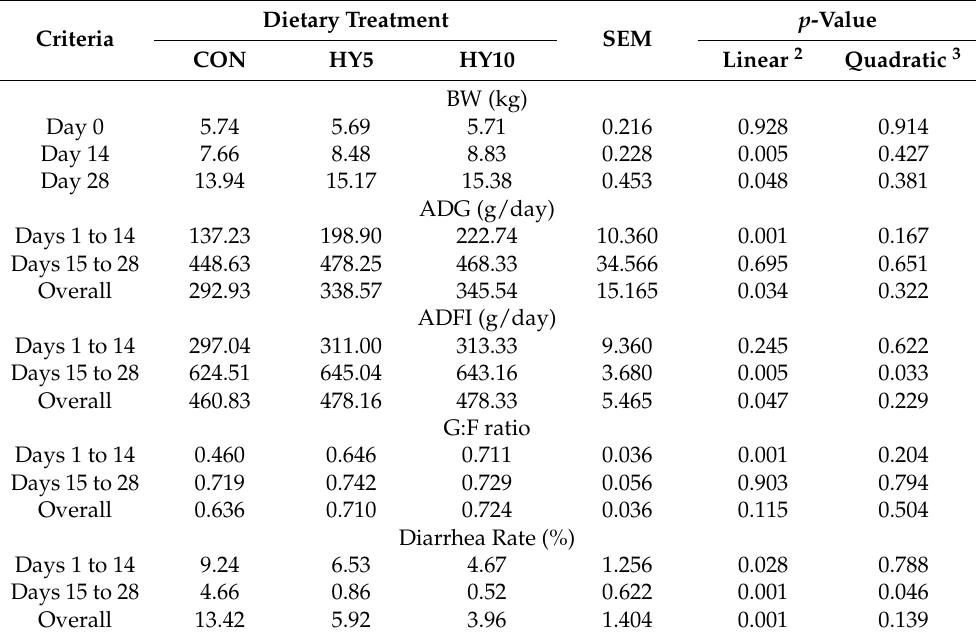
Table 2. Growth performance and diarrheal incidence of early weaned piglets fed HY- supplemented diet 1 .